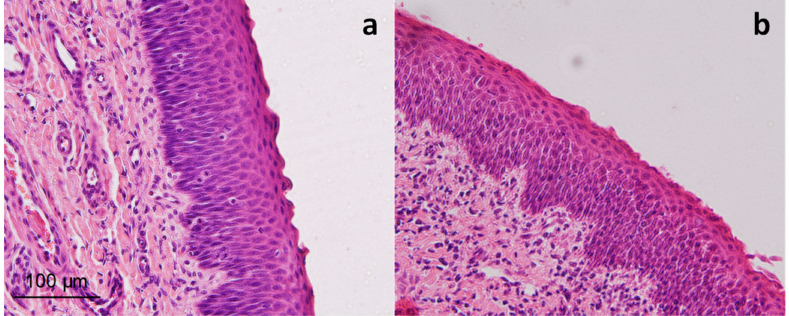
Figure 4. Epithelium structure of nasal porcine mucosa after ex-vivo permeation test. Control mucosa ( a ) and mucosa treated with Cyclamen freeze-dried solution at a human-equivalent dose ( b ) stained with hematoxylin and eosin at 200 × magnification. Scale bar = 100 µ